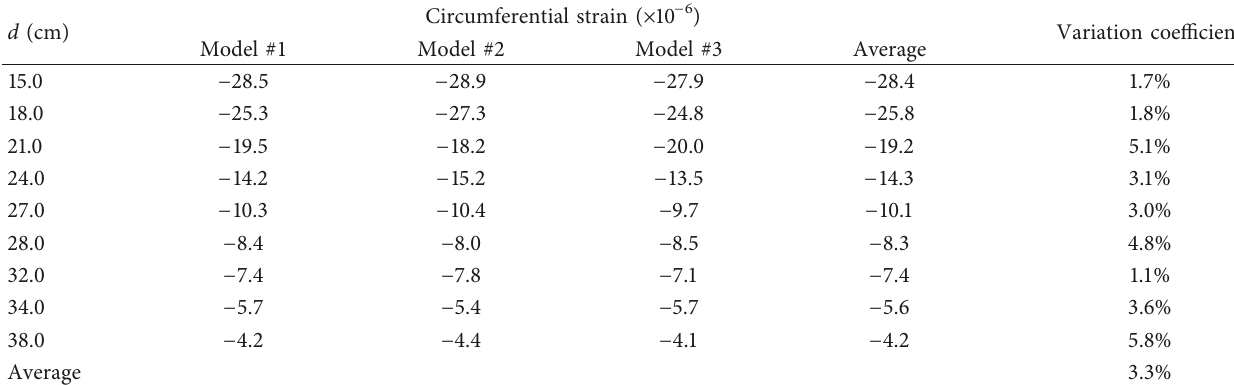
Table 7: Replicate test results of circumferential strain of the AC pavement structure